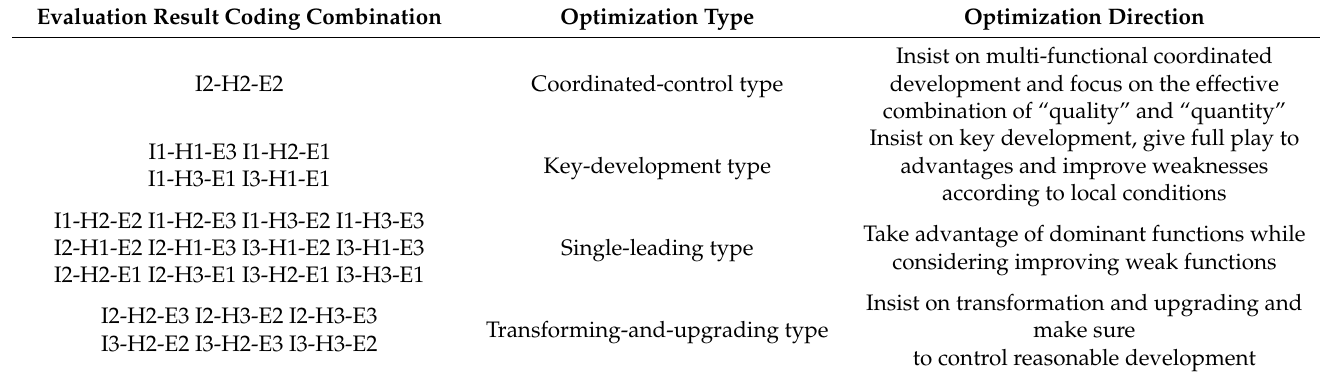
Table 2. Types and optimization directions of rural residential